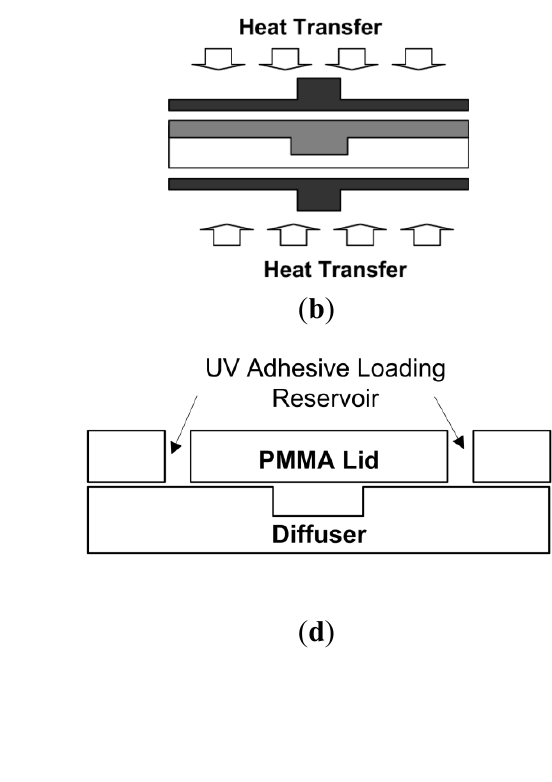
Figure 5. Fabrication procedure of micropump realization. ( a ) Subtract aligned configuration. ( b ) Clamp heat transfer. ( c ) Mold removed. ( d ) Lid assembly with UV interstitial bonding. ( e ) Complete